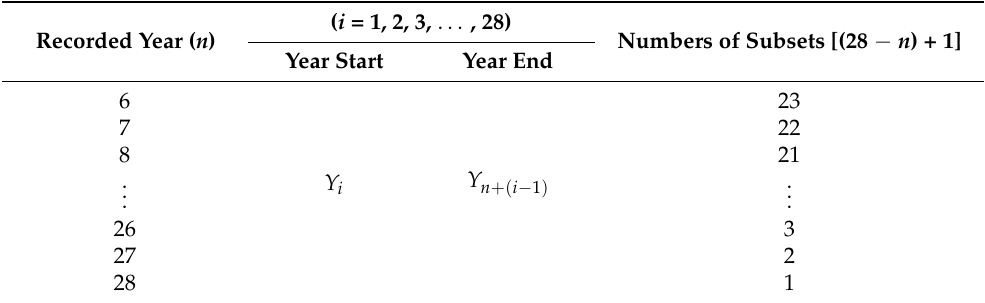
Table 4. The numbers of subsets with n-year data length in 28-year datasets for all four River Basins